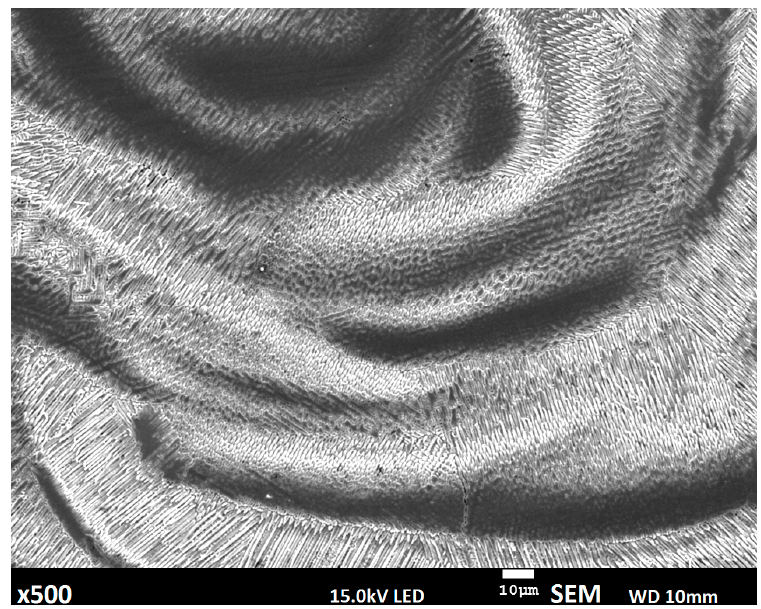
Figure 9. Structure of fusion zone obtained during deposition of filler wire directly on the substrate.